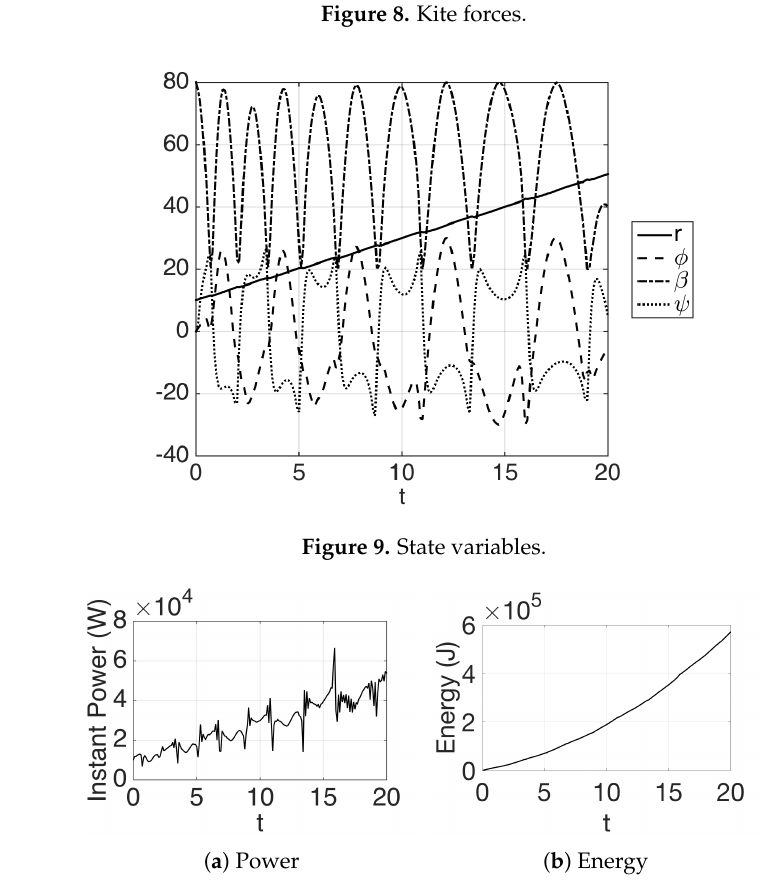
Figure 8. Kite forces.